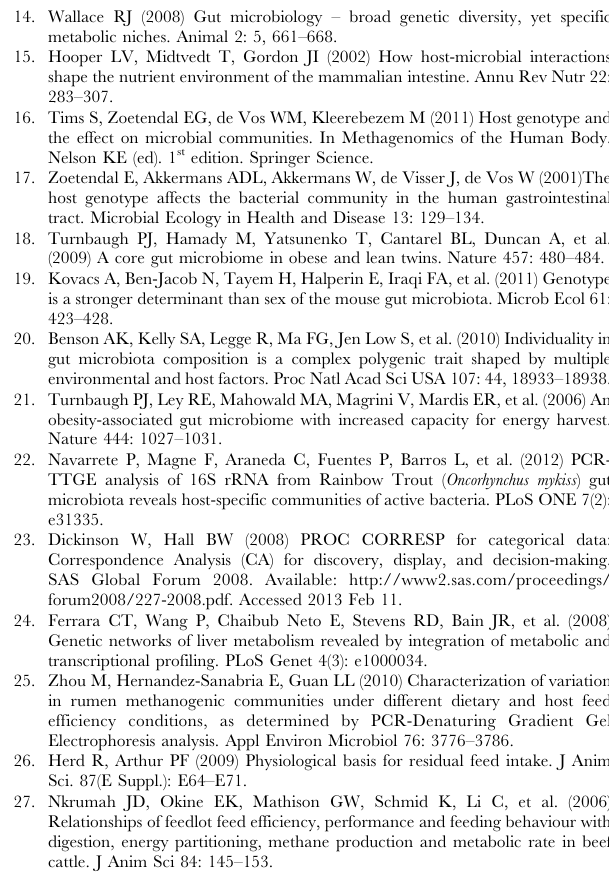
Table S3 Animals included in our study, the breed of the parent sire and the RFI classification under low energy (LE) and high energy (HE)